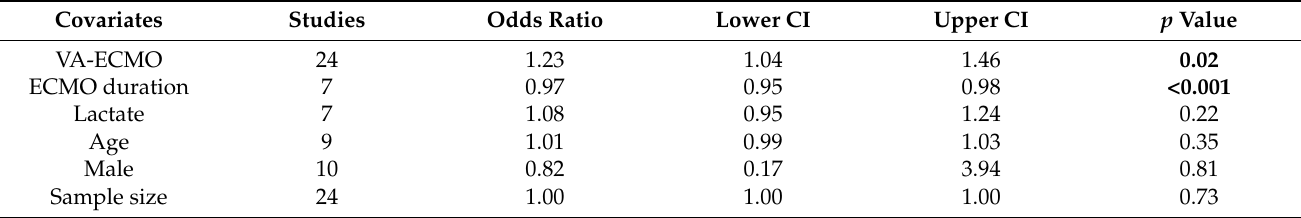
Table 2. Meta-regression analysis of